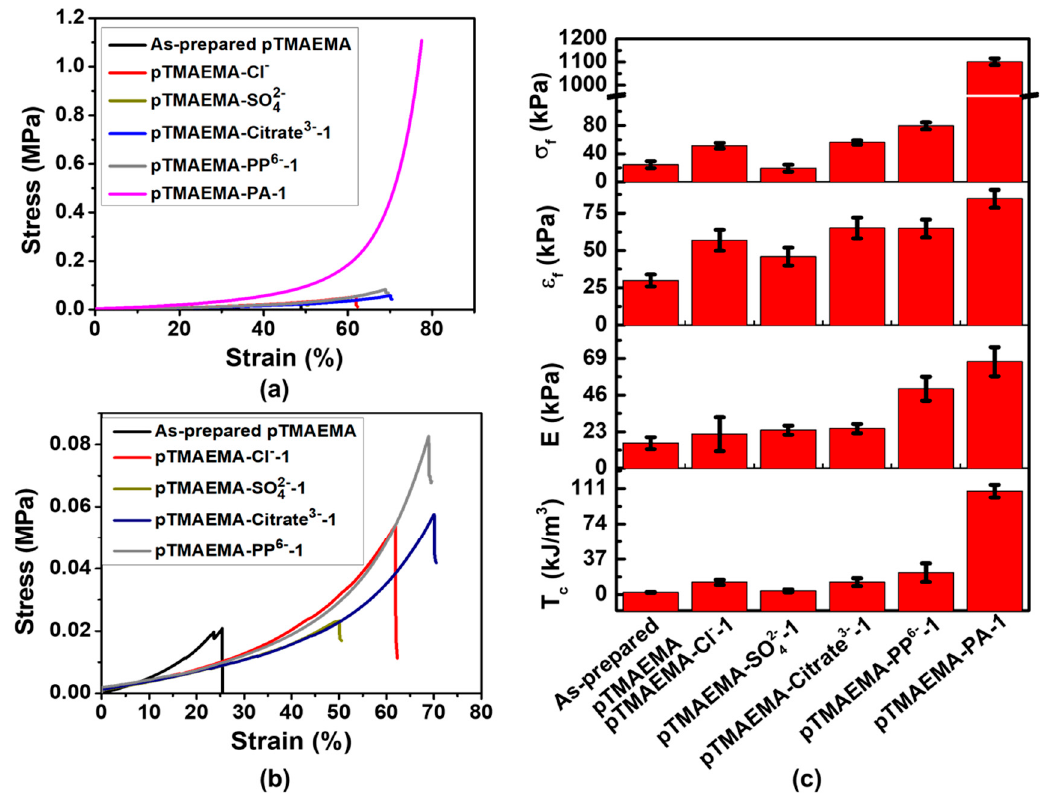
Figure 6. Compressive stress-strain curves of pTMAEMA-anion ( a , b ) and their mechanical properties ( c ): Fracture stress ( σ f ), fracture strain ( ɛ f ), Young ′ s modulus ( E ) and compressive toughness ( T c ) of pTMAEMA after immersing in different electrolyte solution at a concentration of 1 M at room temperature after 1 day.